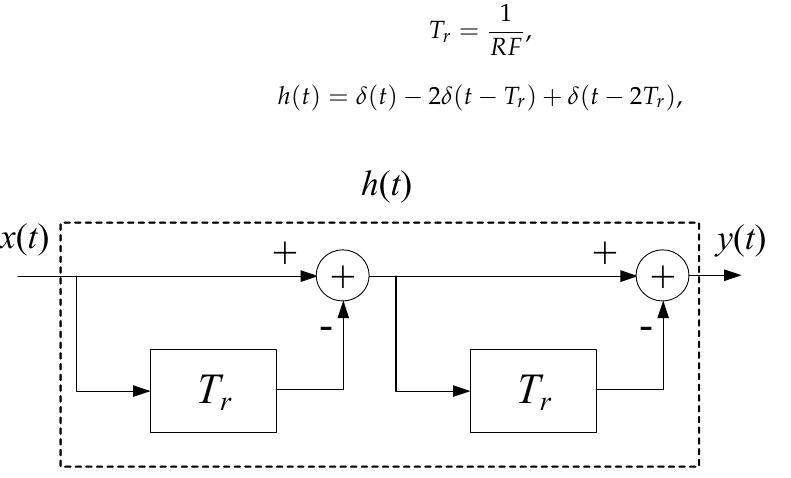
Figure 21. The principle of a double-delay MTI harmonic canceller.